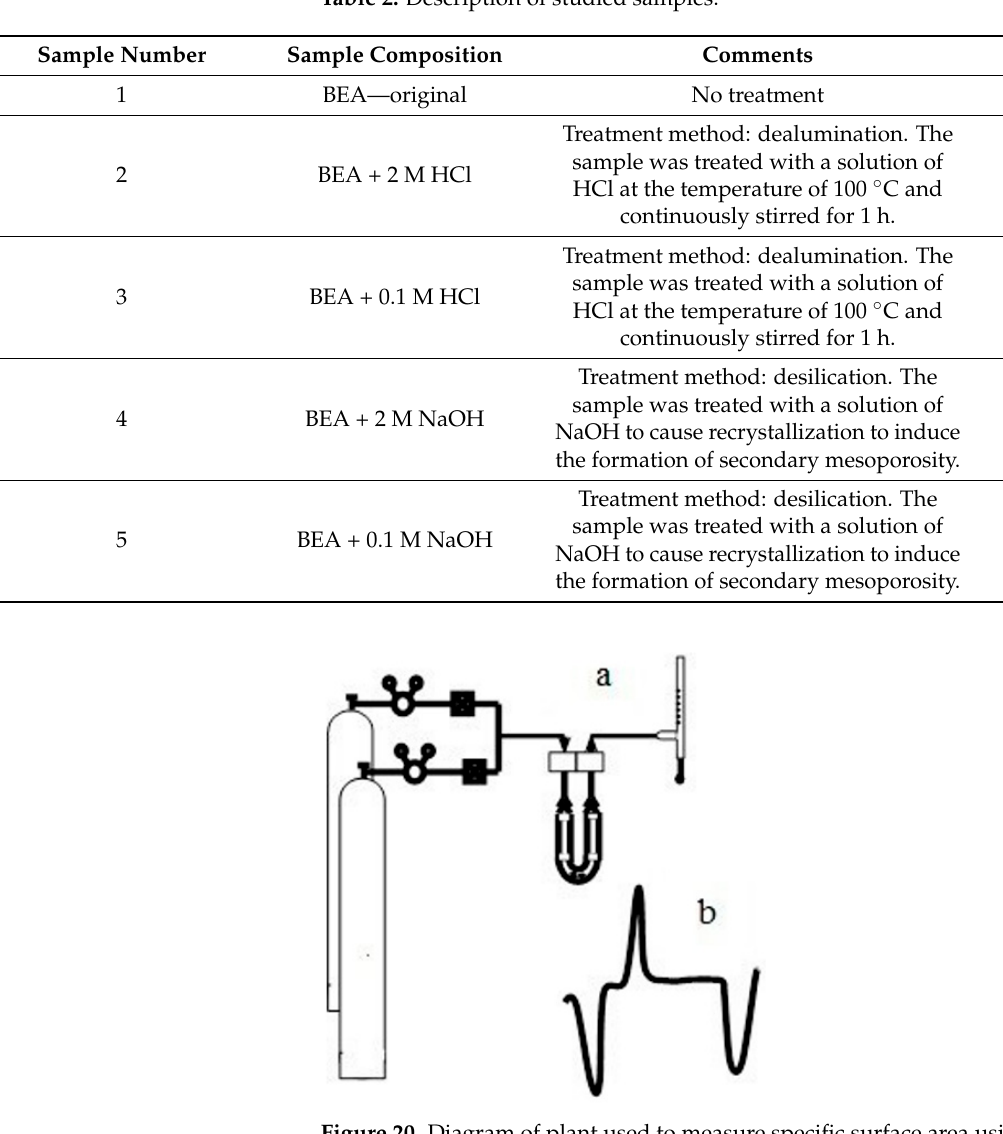
Table 2. Description of studied samples.